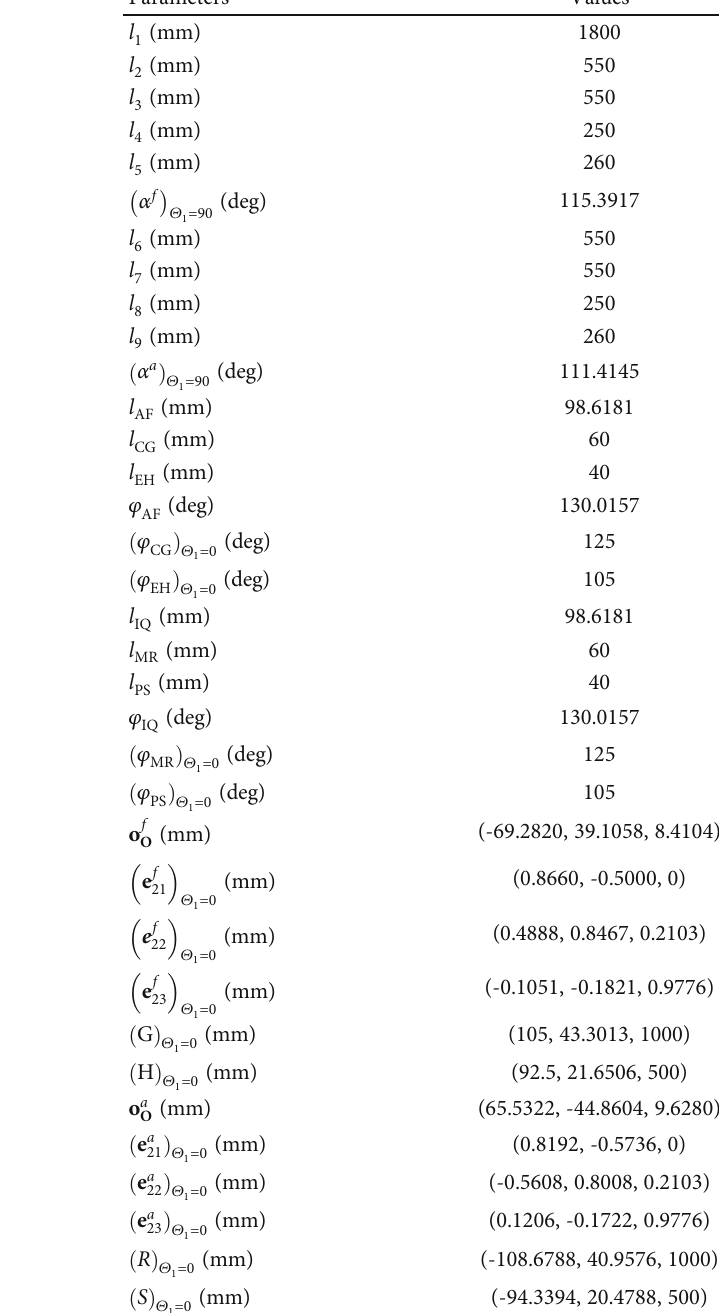
Table 4: Parameters of the DS landing gear.